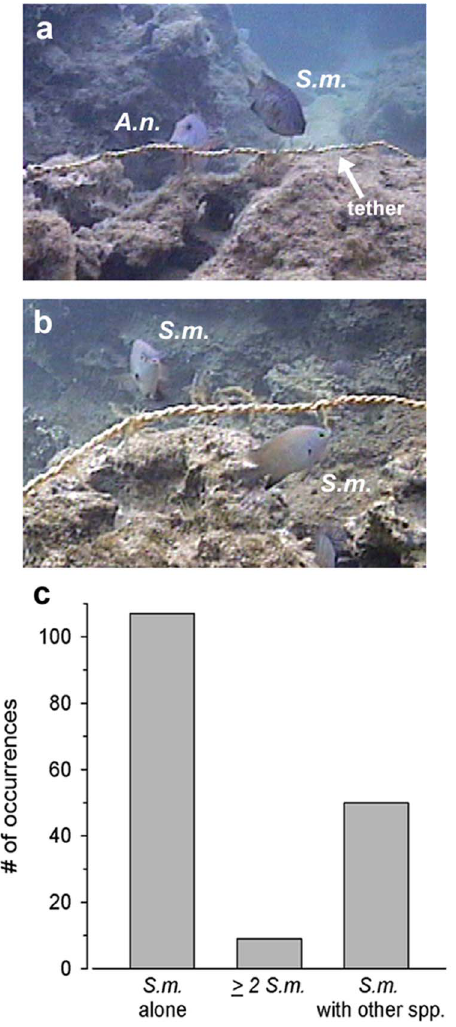
Figure 3. Stegastesmarginatus acts as an opportunistic browser on A.spicifera outside its territorial borders. Examples of Stegastes marginatus feeding outside their territories on tethered Acanthophora spicifera alongside (A) the surgeonfish Acanthurus nigrofuscus ( A.n. ), and (B) another S. marginatus ( S.m. ). C) The total number of occurrences from 400 min of filming when S. marginatus was observed feeding on tethered A. spicifera either alone ( S.m. alone), along with another S. marginatus ( $ 2 S.m. ), or with another fish species in the outside territory treatments ( S.m. with other spp.).